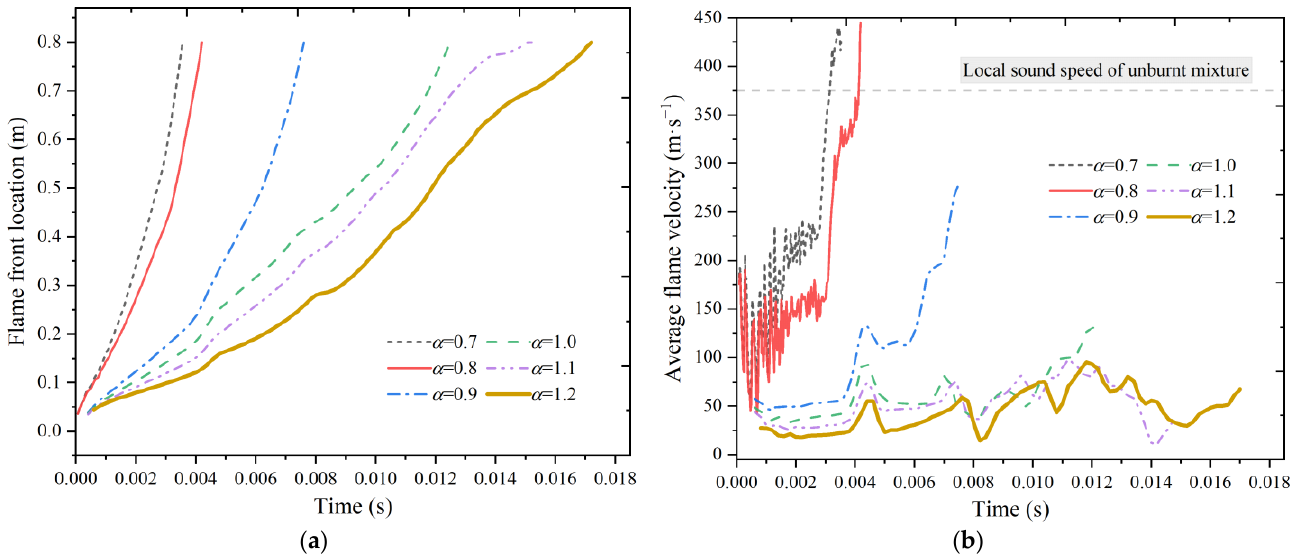
Figure 13. Effects of the initial excess air coefficient on the flame propagation: ( a ) flame front position vs. time; ( b ) average flame velocity vs. time.